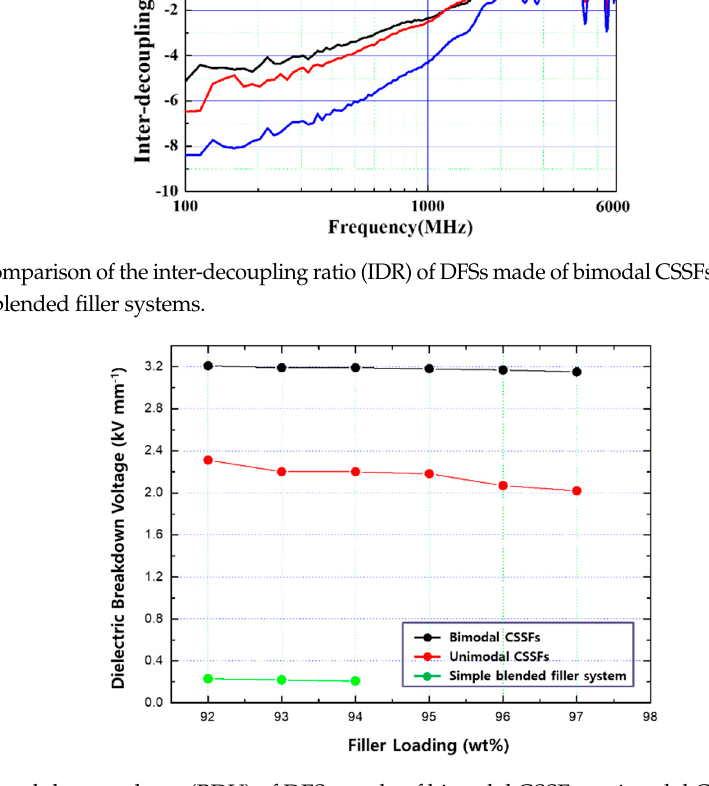
Figure 10. Breakdown voltage (BDV) of DFSs made of bimodal CSSFs, unimodal CSSFs, and simple blended filler systems.